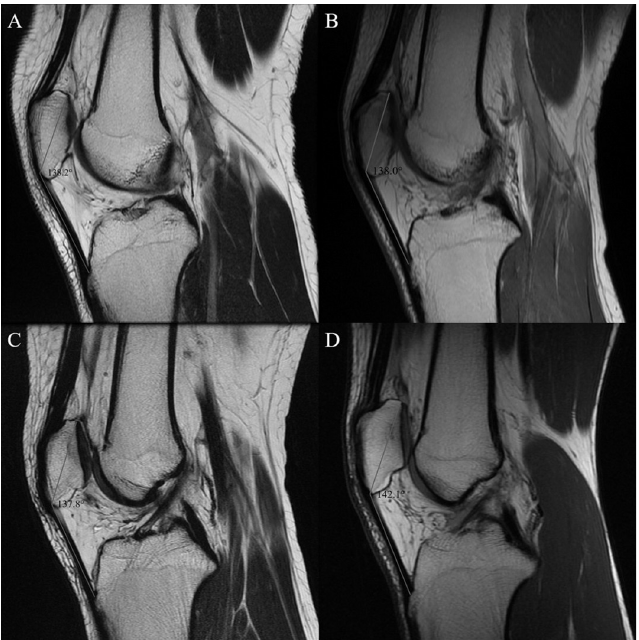
Fig 1. Measurements and comparison of patella-patellar tendon angle (PPTA) in patients who complained anterior knee pain. In study group, measured PPTA on sagittal proton density-weighted images was (a) 138.2˚ in a 21-year-old man with medial patellar plica syndrome, (b) 138.0˚ in a 22-year-old man with chondromalacia patella, and (c) 137.8˚ in a 21-year-old man with infrapatellar fat pad syndrome. (d) However, in a 22-year-old man with no abnormality on MRI and diagnostic arthroscopy, the PPTA was 142.1˚ which was significantly higher than that of patients in study group.